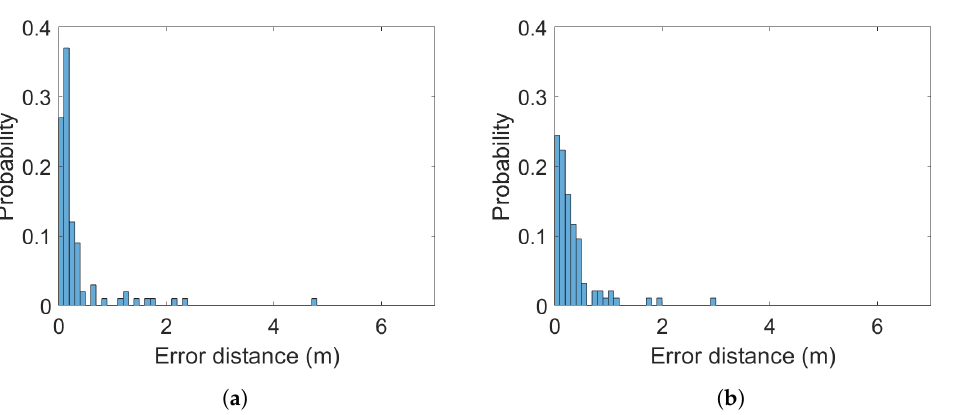
Figure 5. Histograms of error distances across all ground-truth points for ( a ) Pozyx and ( b ) GoT for 2 m altitude (bins: 0.1